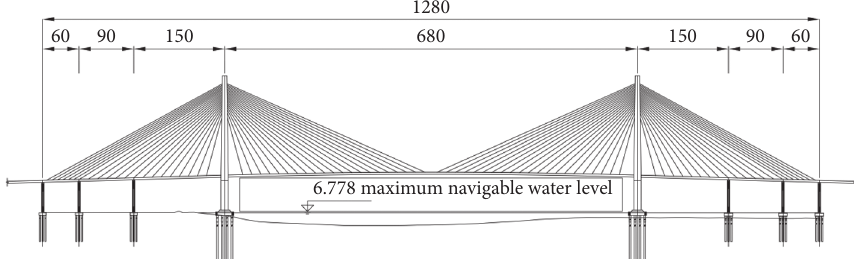
Figure 1: The overall layout of the double-tower cable-stayed bridge (unit: m).